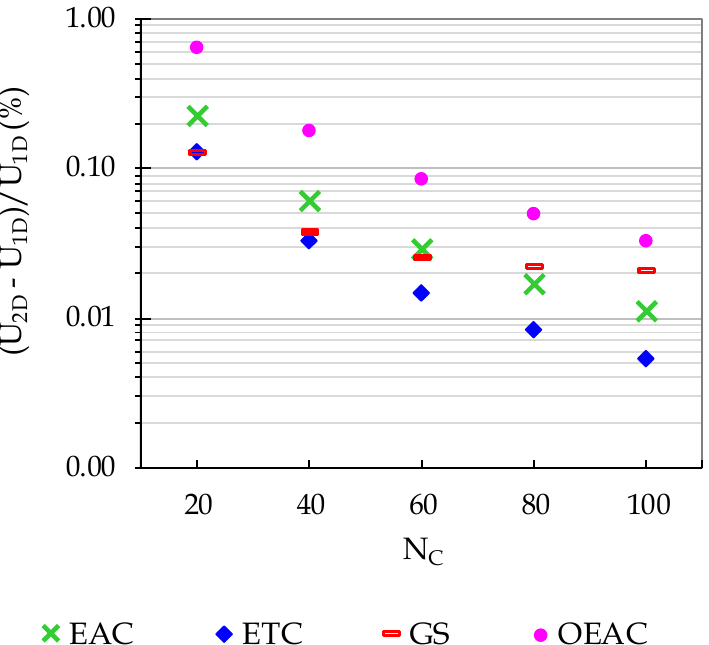
Figure 13. Steady-state mean velocity error according to the total number of cylinders (log scale).